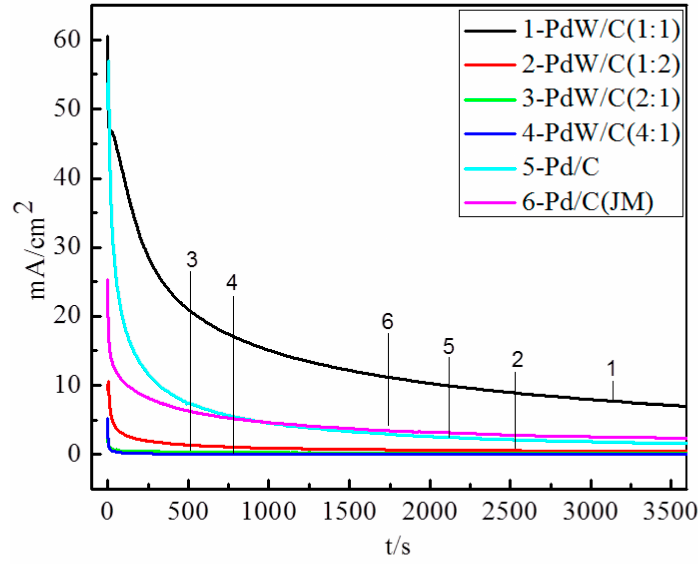
Figure 5. Chronoamperometry curves of Pd-based catalysts in 1 M KOH +1 M C 2 H 5 OH solution at a fixed potential of − 0.3 V at 50 mV s − 1